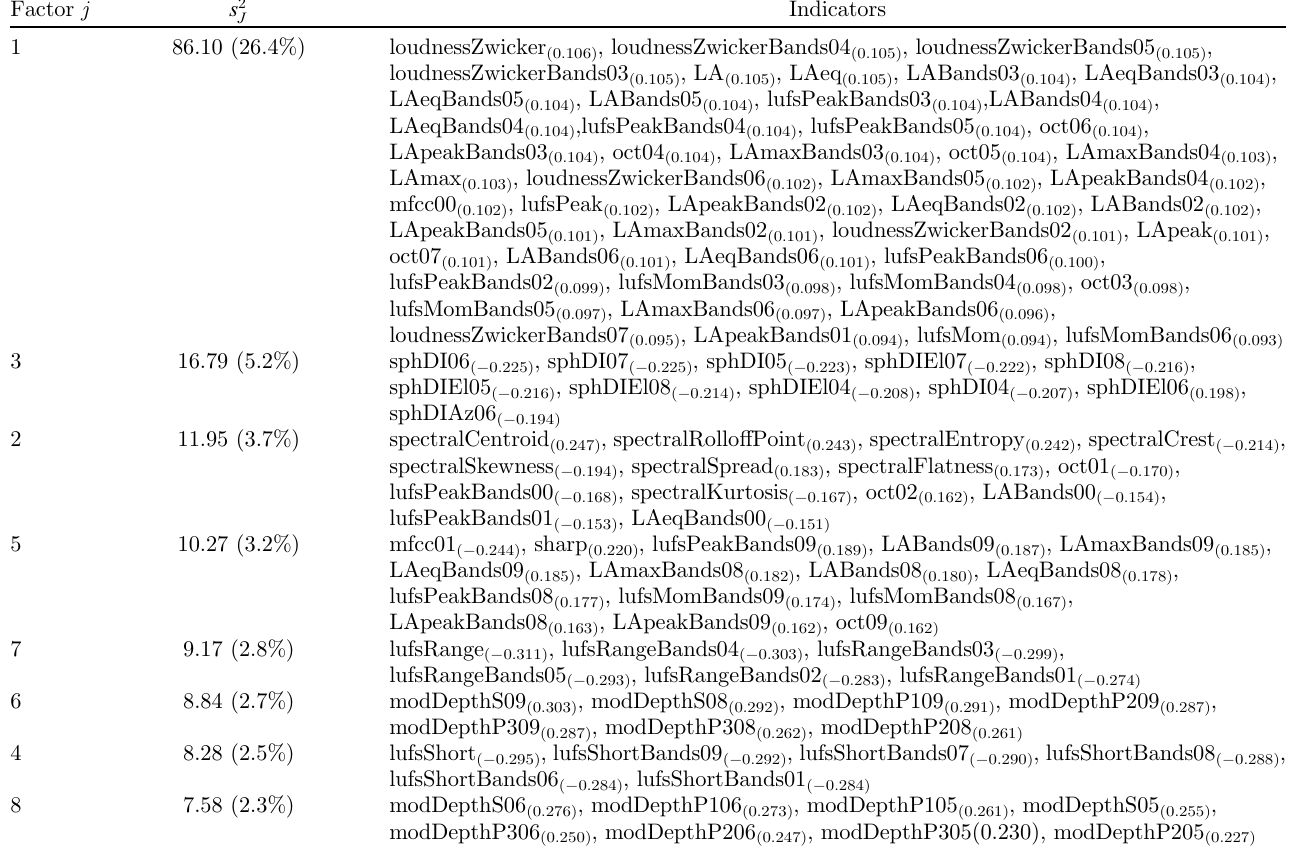
Table 4. Indicator composition of the 8 most relevant factors. Trailing index numbers denote the respective frequency band ID as listed in Table 2. Factors in parentheses indicate respective